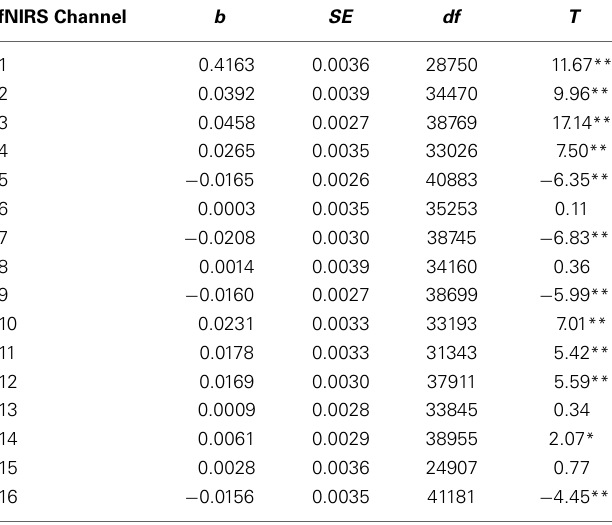
Table 4 | Multilevel analyses comparing oxy-Hb levels for multiple-move and zero-move conditions for all participants ( N =